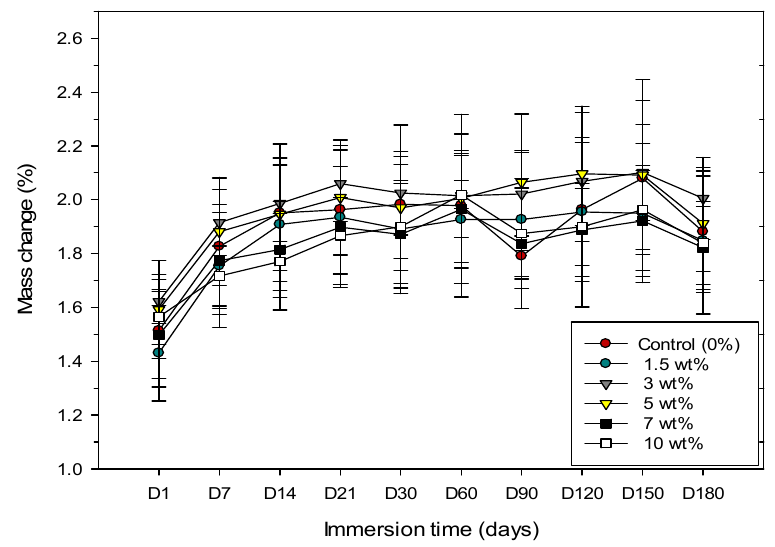
Figure 1. Line graph illustrating the mass change of specimens from six groups immersed in distilled water over 180 days.